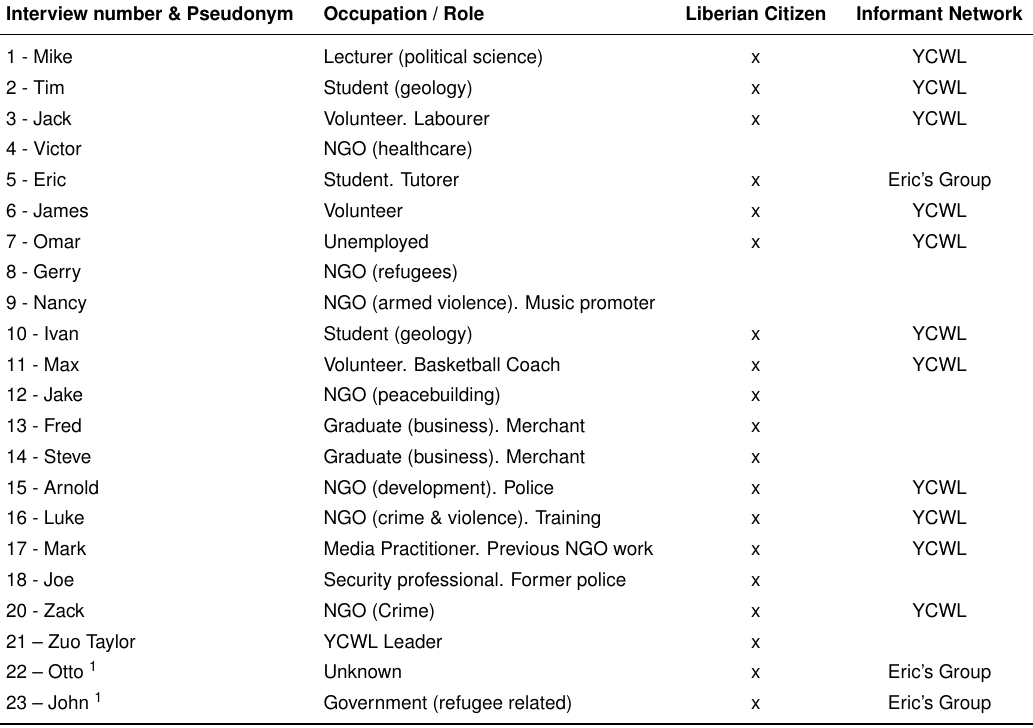
Table 1. Informant’s self-identified background and relation to case studies.